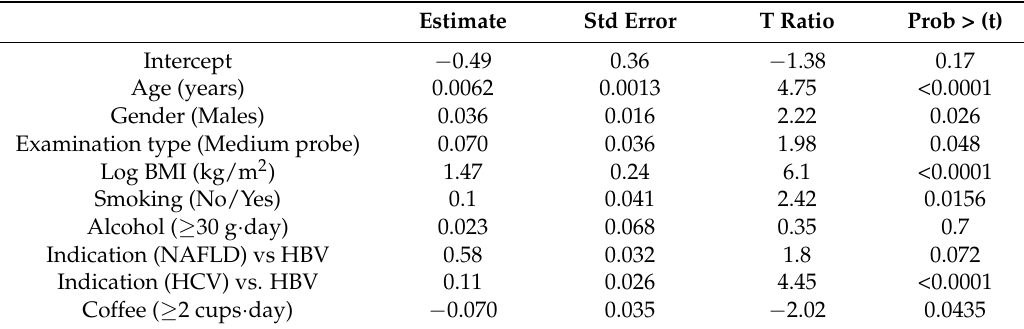
Table 3. Multivariate analyses between liver stiffness and coffee consumption after adjustment for